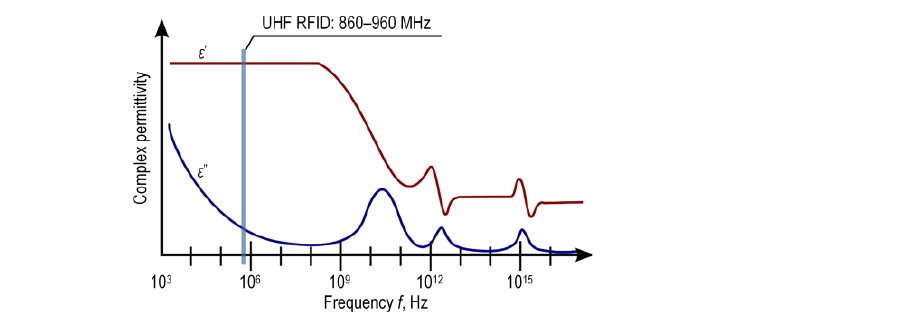
Figure 2. Dependence of complex permittivity on frequency, taking into account the UHF band of radio object identification systems.